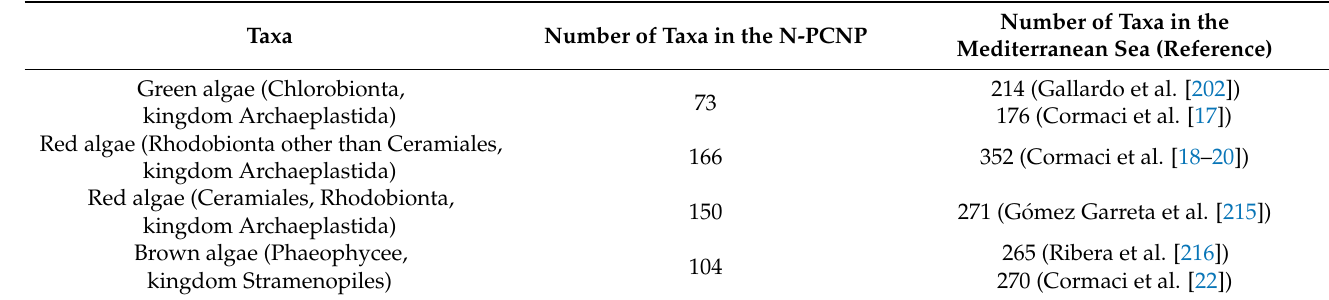
Table 2. Number of taxa at the scale of the study area and of the whole Mediterranean Sea. Note that the accepted taxa generally follow the treatment of Cormaci et al. (2012, 2014, 2017, 2020, 2021), but sometimes other authors, such as Guiry and Guiry (2022), are followed: see text in Section 3 for